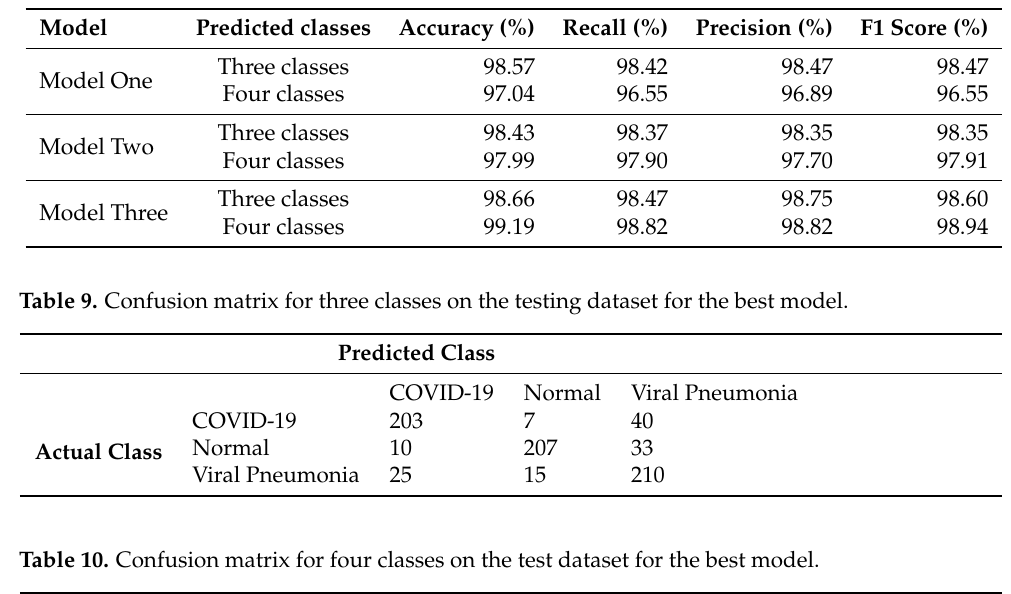
Table 8. Cross-validation results on the testing dataset for both three classes and four classes.